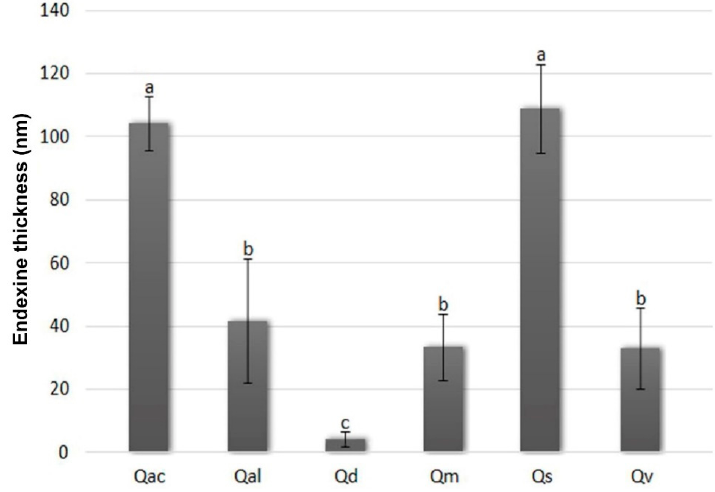
Figure 6. Endexine thickness of oak pollen grains. Abbreviations: Qac, Q. acutissima ; Qal, Q. aliena ; Qd, Q. dentata ; Qm, Q. mongolica ; Qs, Q. serrata ; Qv, Q. variabilis . Di ff erent letters above bars along the x